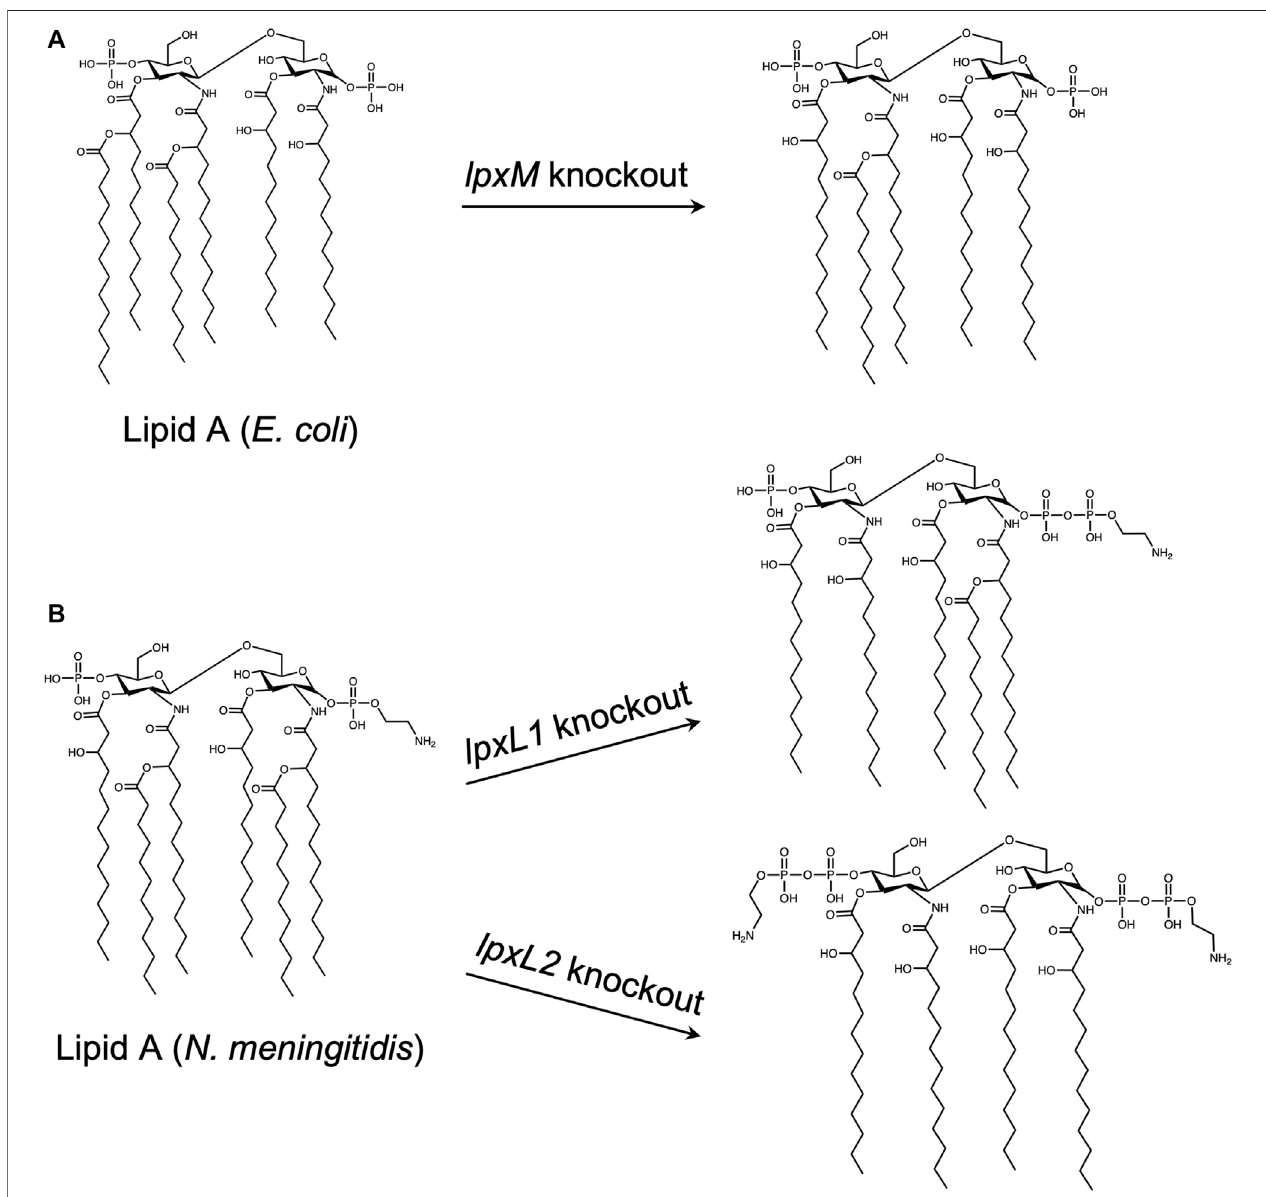
FIGURE7| EffectofgeneknockoutsonthestructureofLipidA.ThelipidAdomainoflipopolysaccharide(LPS)ismainlyresponsibleforthetoxicityassociatedwith gram negative bacteria. As outer membrane vesicles (OMVs) natively contain LPS, and LPS is necessary for membrane stabilization, many studies have focused on detoxifying LPS by modifying the structure of lipid A, rather than removing it entirely. Both E. coli and N. meningitidis lipid A structures are natively hexa-acylated. Knockout of lpxM in E. coli (A) and lpxL1 in N. meningitidis (B) , (top) results in a penta-acylated lipid A, whereas lpxL2 knockout in N. meningitidis (B) ,(bottom) results in a tetra-acylated species. (Van Der Ley et al., 2001; Mamat et al., 2015; Chen et al., 2016).